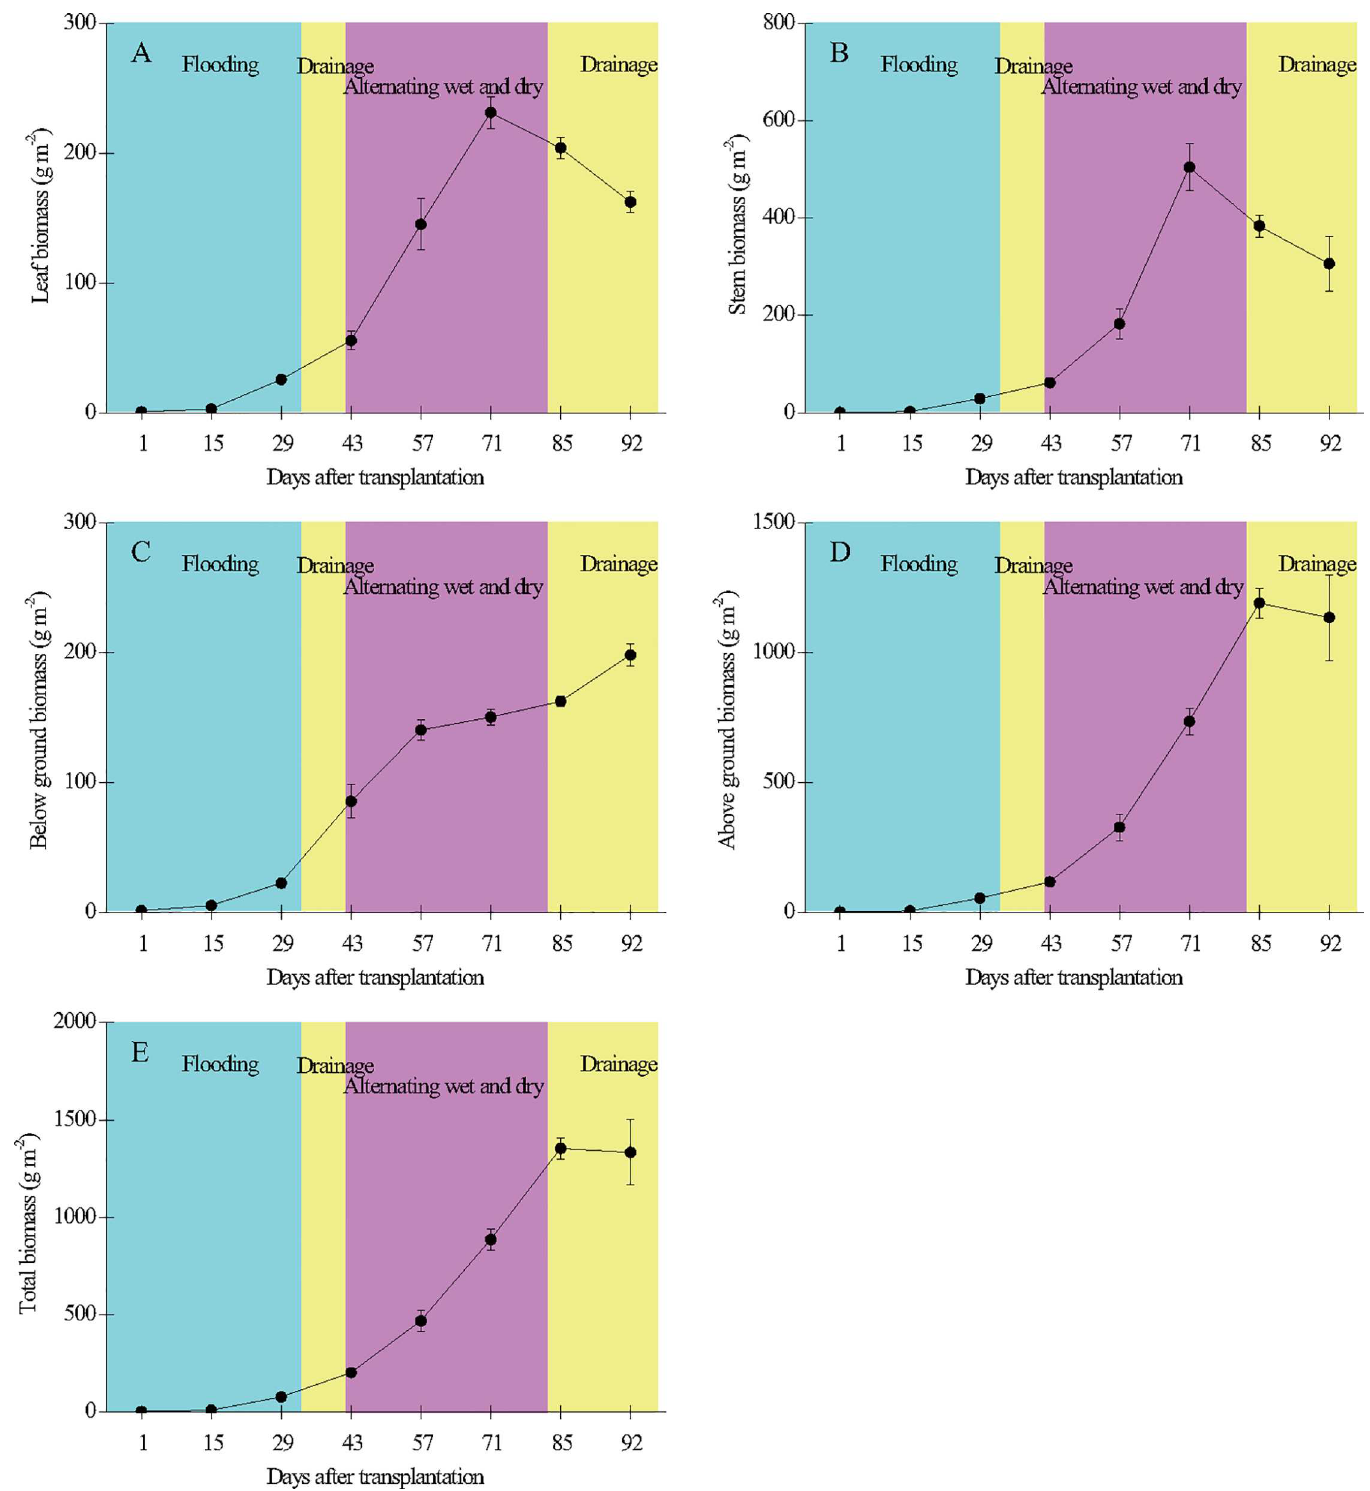
Fig 7. Temporal variation of plant leaf biomass (A), stem biomass (B), belowground biomass (C), aboveground biomass (D, sum of leaf, stem, and grain biomasses), and total biomass (E, sum of above- and belowground biomasses) in the paddy field. Error bars indicatethe standard error of the mean of triplicate